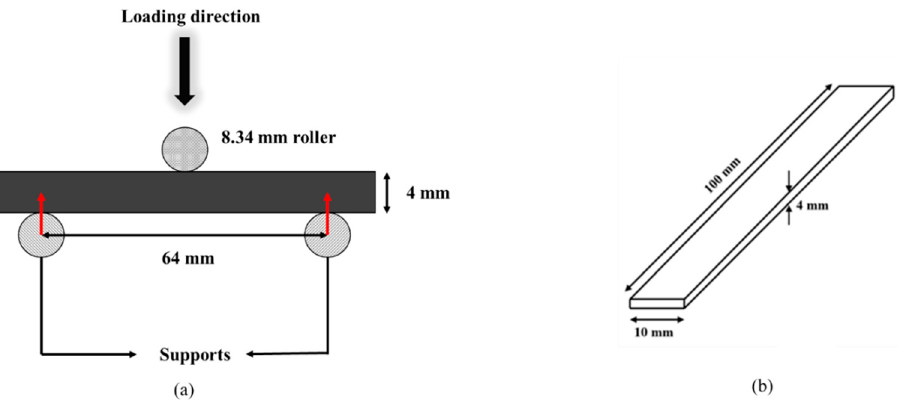
Figure 4. ( a ) Schematic of Experimental Setup; ( b ) dimensions of bending specimen used in this study.